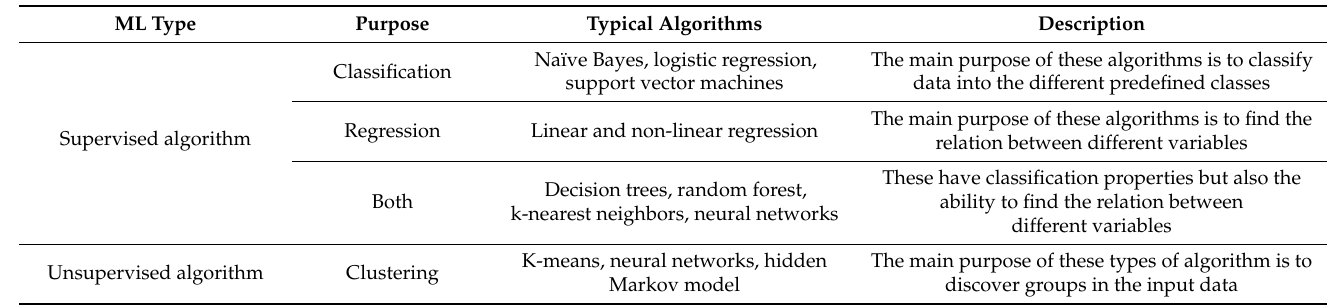
Table 1. Summary of main ML technique